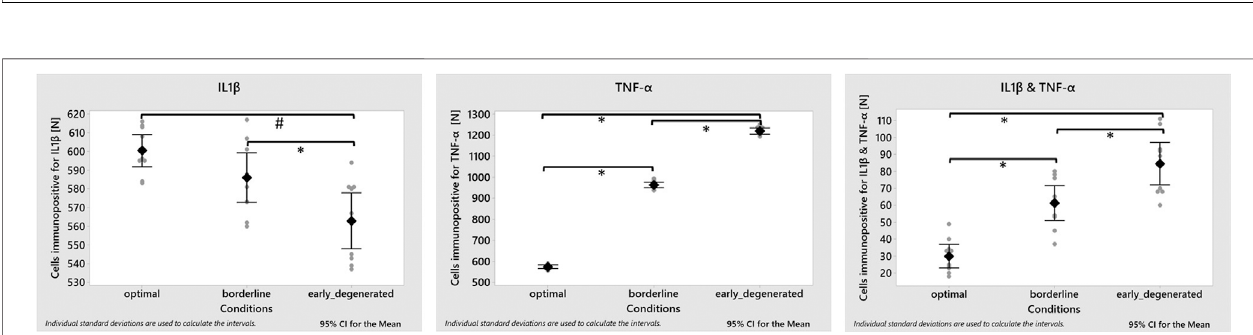
FIGURE 9 | Model predictions for an in fl ammatory environment within an optimal, borderline and early degenerated nutritional environment. Average amount of in fl amedcells (square) withcorresponding 95%con fi denceinterval andindividualvalues (greydots) ( n (cid:2) 10simulationsper condition). ANOVAtestshowedsigni fi cant differences between conditions in the three groups studied ( p -value < 0.001). Post-hoc analysis showed that the number of cells immunopositive for IL1 β were signi fi cantlylowerinthedegeneratedconditionscomparedwiththeoptimalandborderlineconditions( p -value0.000and0.017,respectively).Ontheotherhand,in the case of cells immunopositive for TNF- α and for IL1 β &TNF- α , signi fi cant differences were observed between the three conditions ( p -value <